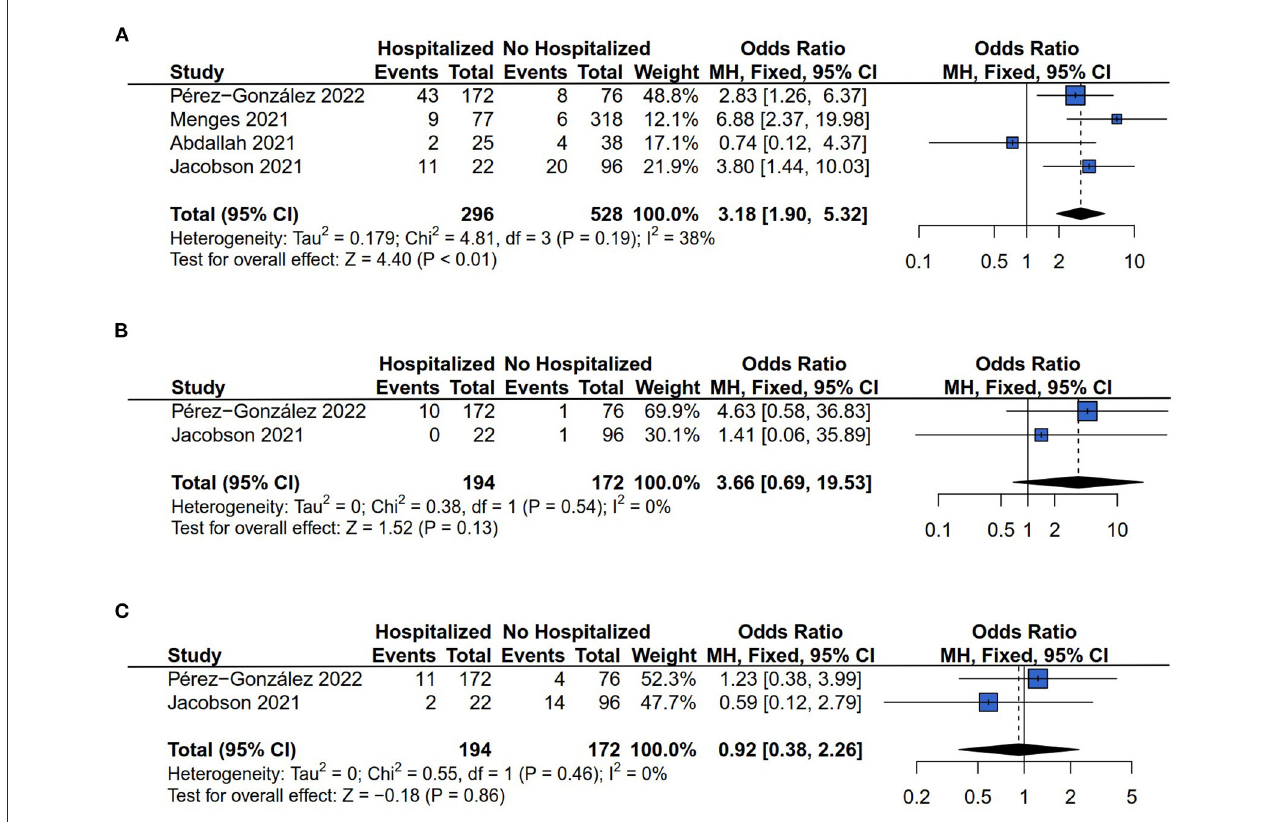
FIGURE4 Forest plot for meta-analysis of respiratory symptoms risk among Hospitalized vs. non-hospitalized COVID-19 survivors. (A) Dyspnea risk; (B) Cough risk; (C) Chest pain